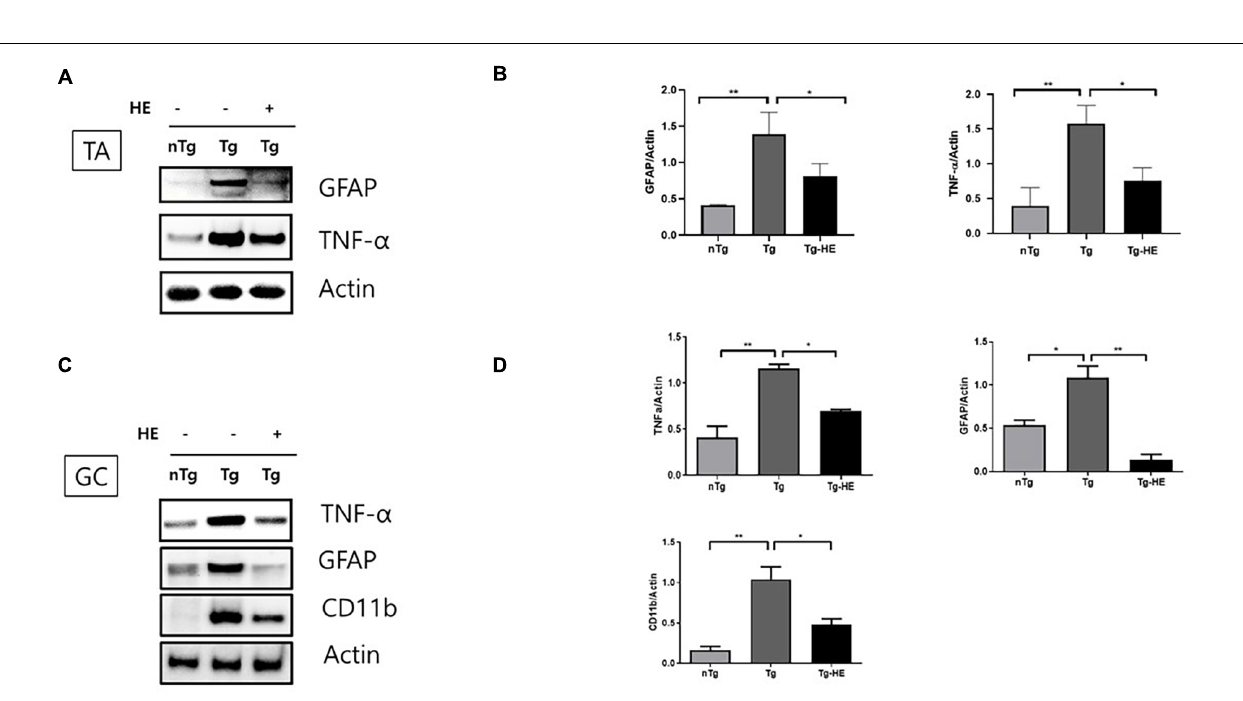
FIGURE 2 | Herbal extract (HE) relieves inflammation in the tibialis anterior (TA) and gastrocnemius (GC) of hSOD1 G93A mice. (A–D) Western blotting of non-transgenic mice (nTg, N = 3), hSOD1 G93A mice (Tg, N = 3), and HE-treated hSOD1 G93A mice (Tg-HE, N = 3). (A) Data for Western blotting analysis of glial fibrillary acidic protein (GFAP) and tumor necrosis factor (TNF)- α in the TA. (B) Quantification of levels of GFAP and TNF- α with respect to levels of actin that is used as a loading control. (C) GC is immunoblotted with TNF- α , GFAP, and cluster of differentiation 11b (CD11b) using nTg, Tg, and Tg-HE ( N = 3). (D) Quantification of levels of TNF- α , GFAP, and CD11b with respect to that of or actin that is used as a loading control. Data are shown as mean ± SEM. The statistical analyses were conducted with one-way ANOVA followed by Bonferroni’s multiple comparison tests (* p < 0.05 and ** p <